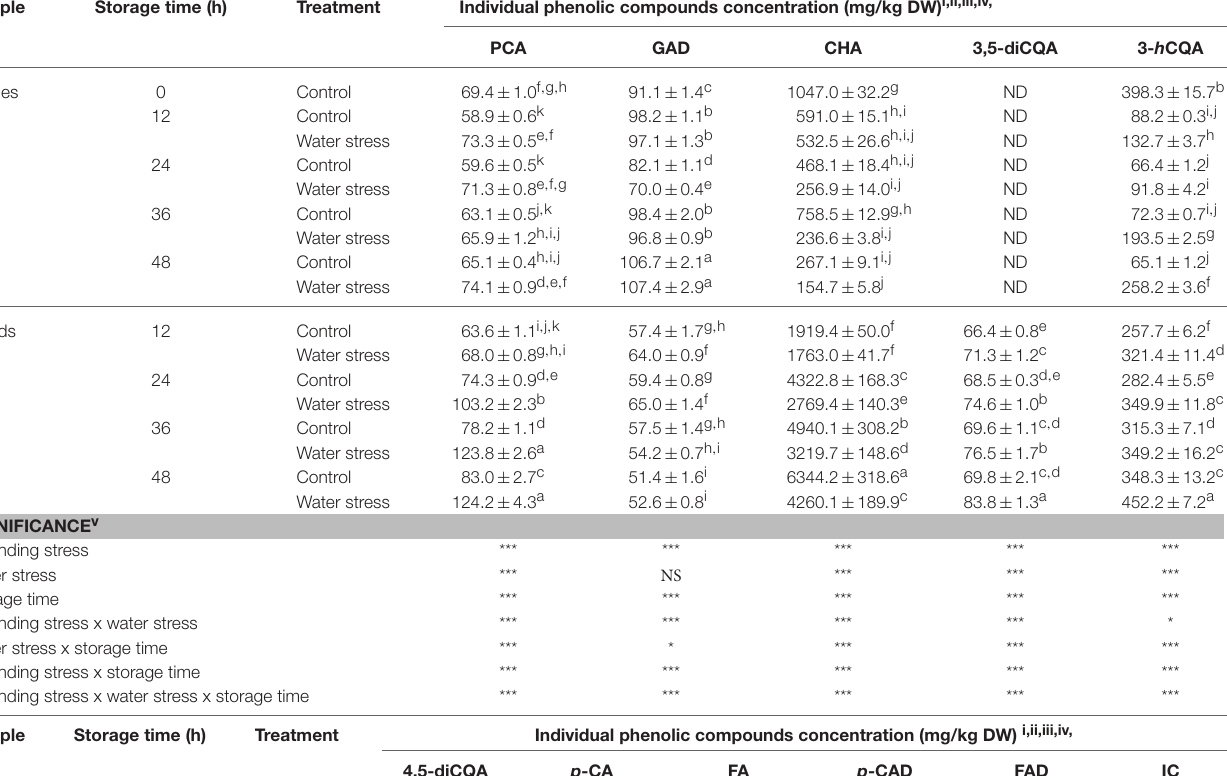
TABLE 4 | Effects of wounding and water stress on the concentration of individual phenolic compounds during storage of carrots.